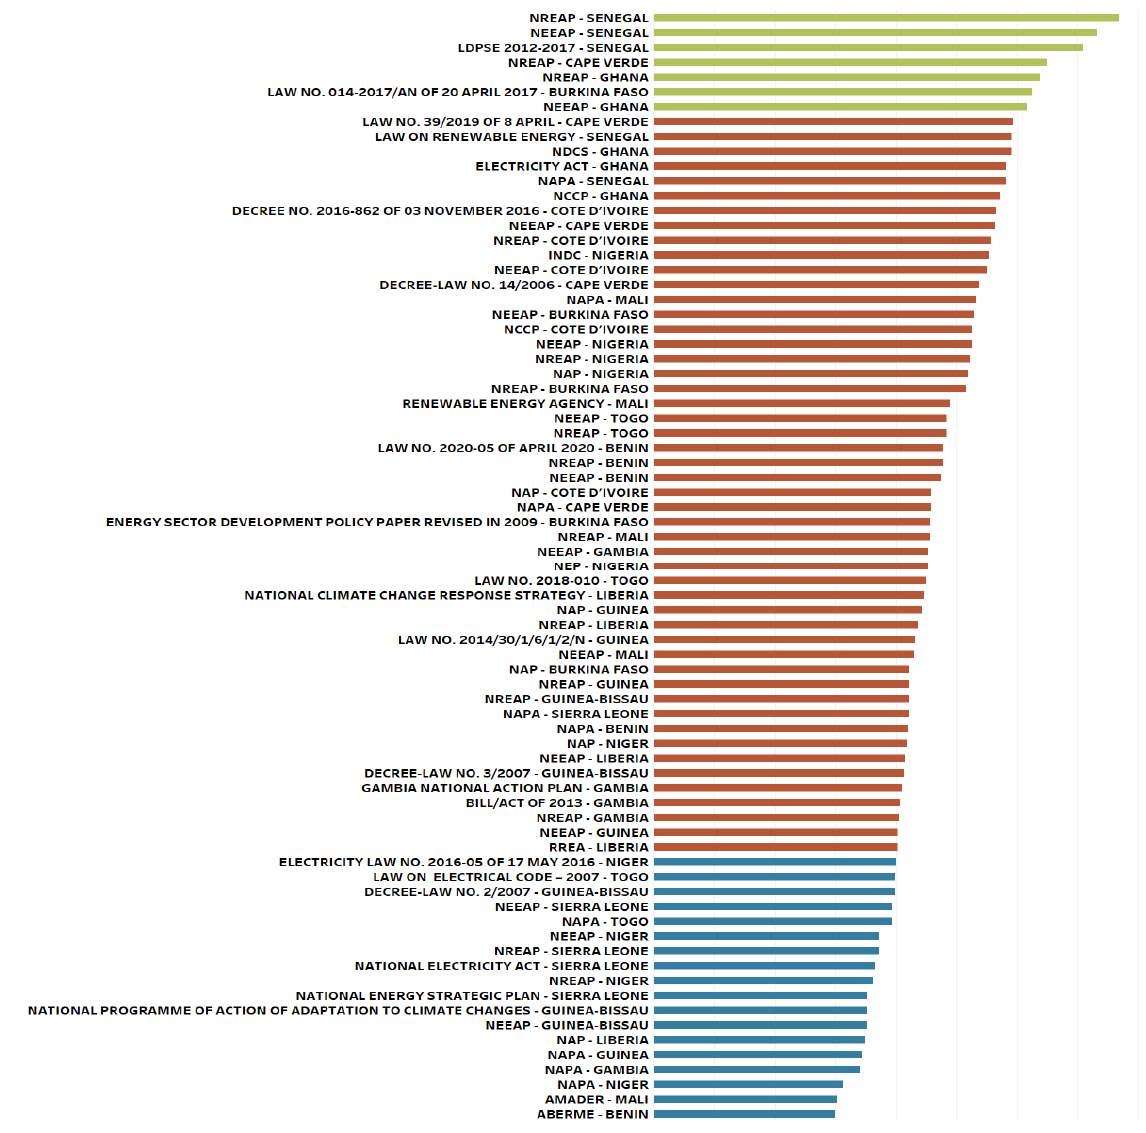
Figure 5. Final graph of policies .